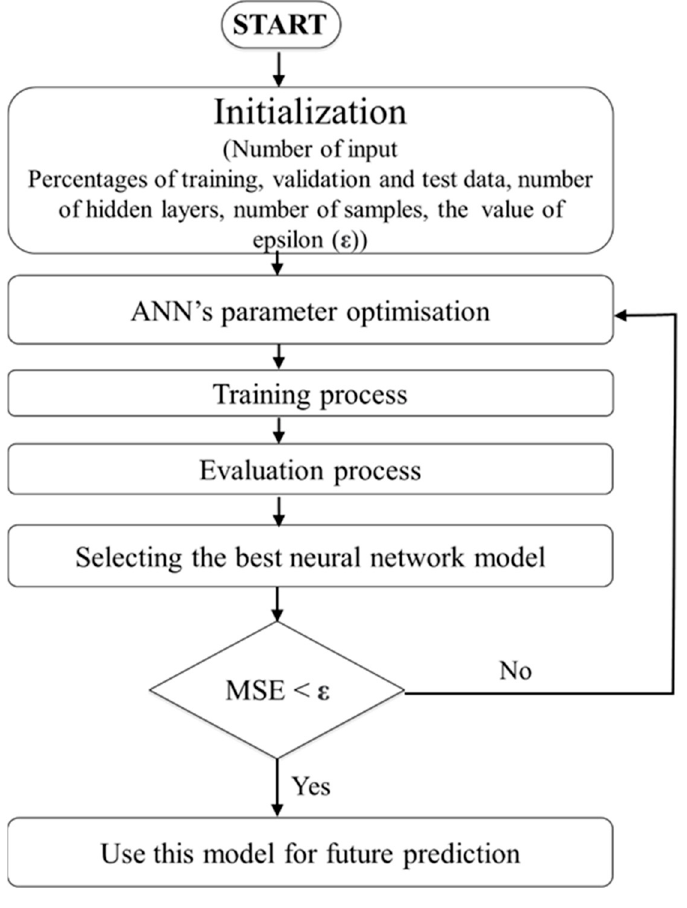
Figure 9. Artificial neural network flowchart for calibrating the proposed sensor.